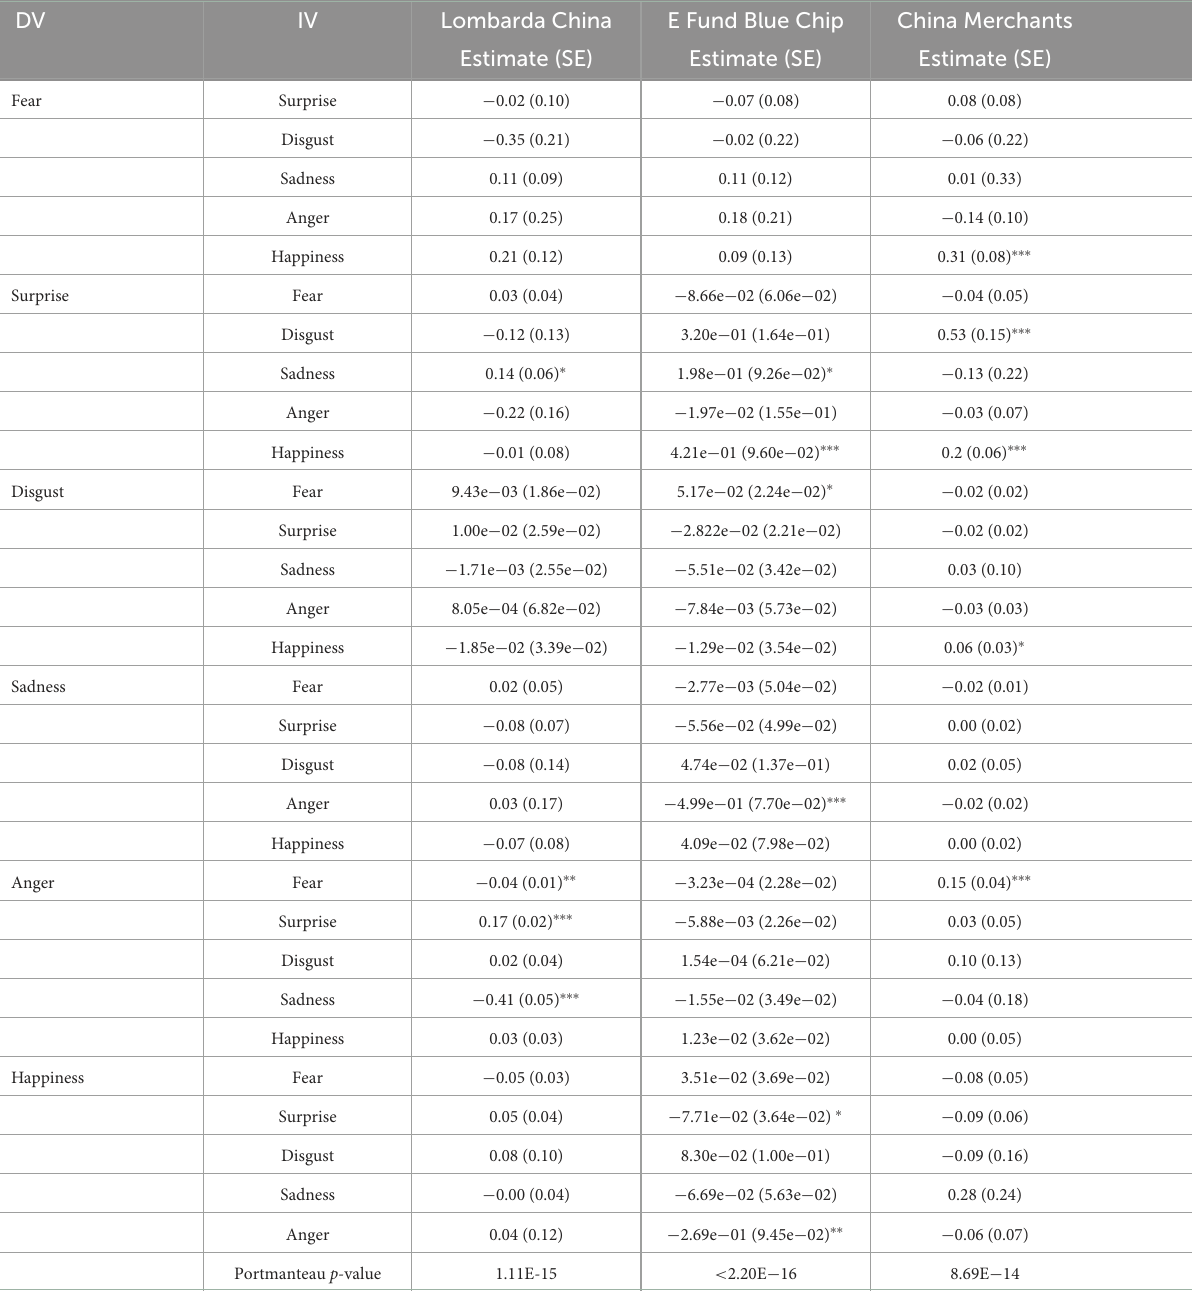
TABLE 5 Vector auto-regressive model ( p = 1) of emotions. DV IV